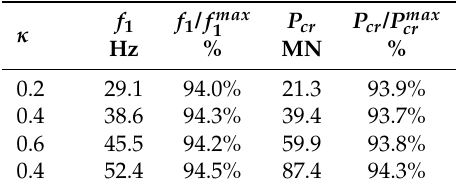
Table 5. Nadir points for different values of κ